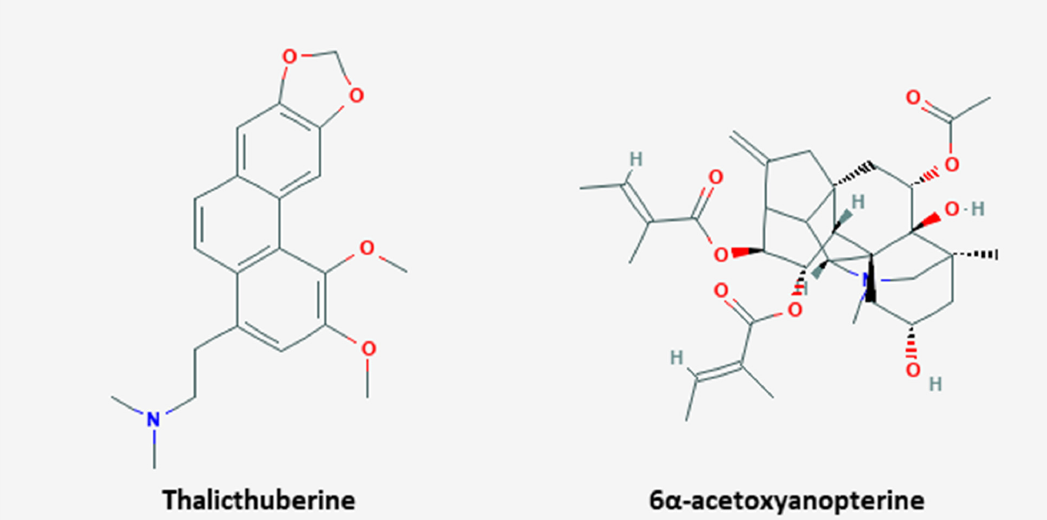
Figure 4. Chemical structures of compounds derived from natural products sensitizing drug resistance. Table 5. Drug resistance sensitizing natural products.